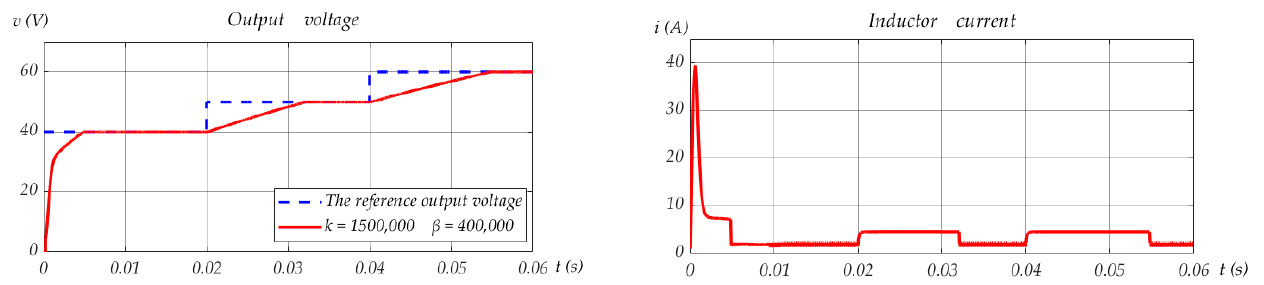
Figure 6. Simulation results with step change in reference output voltage.